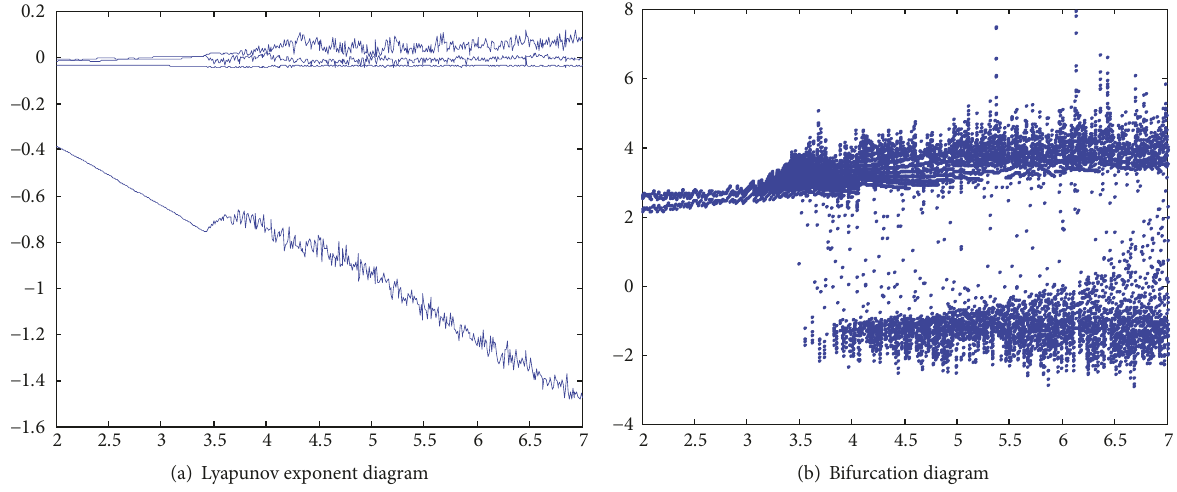
Figure 3: Dynamics of given memristor-based system with different a .